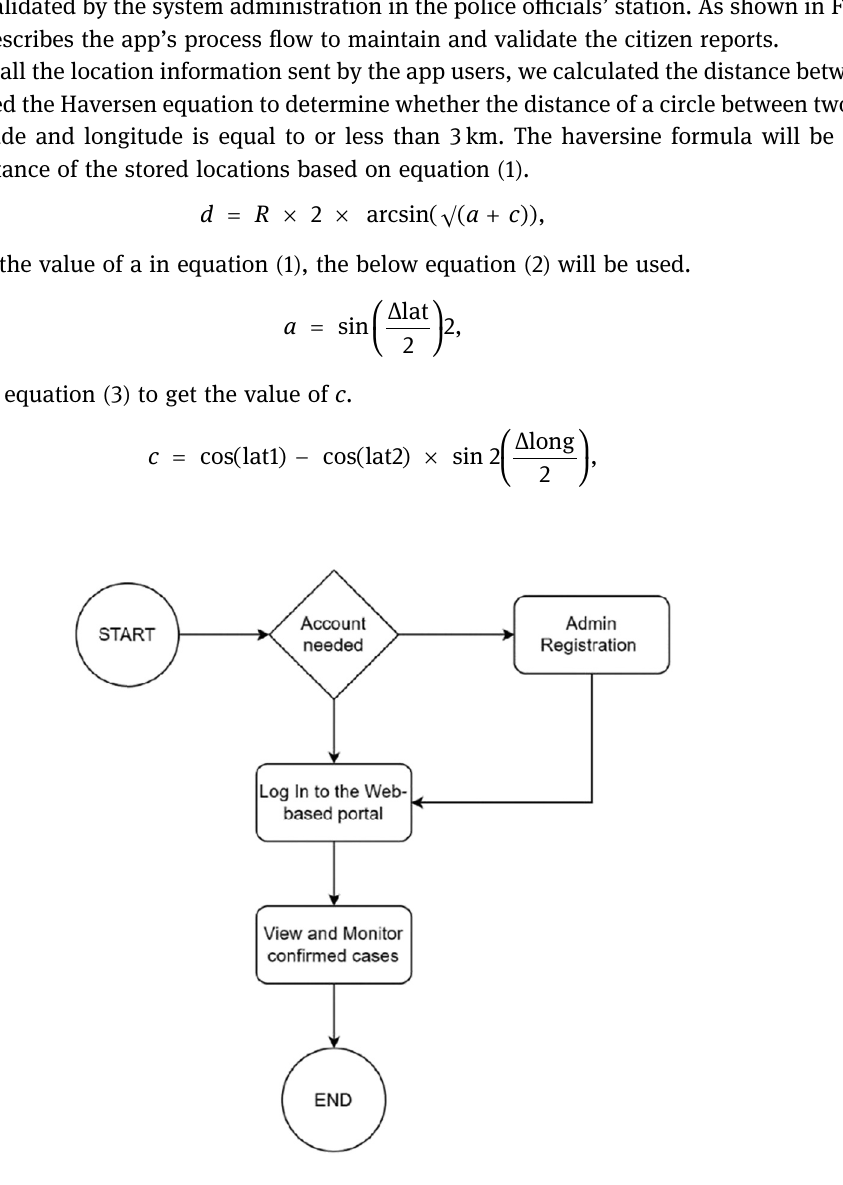
Figure 5: Desktop app process fl